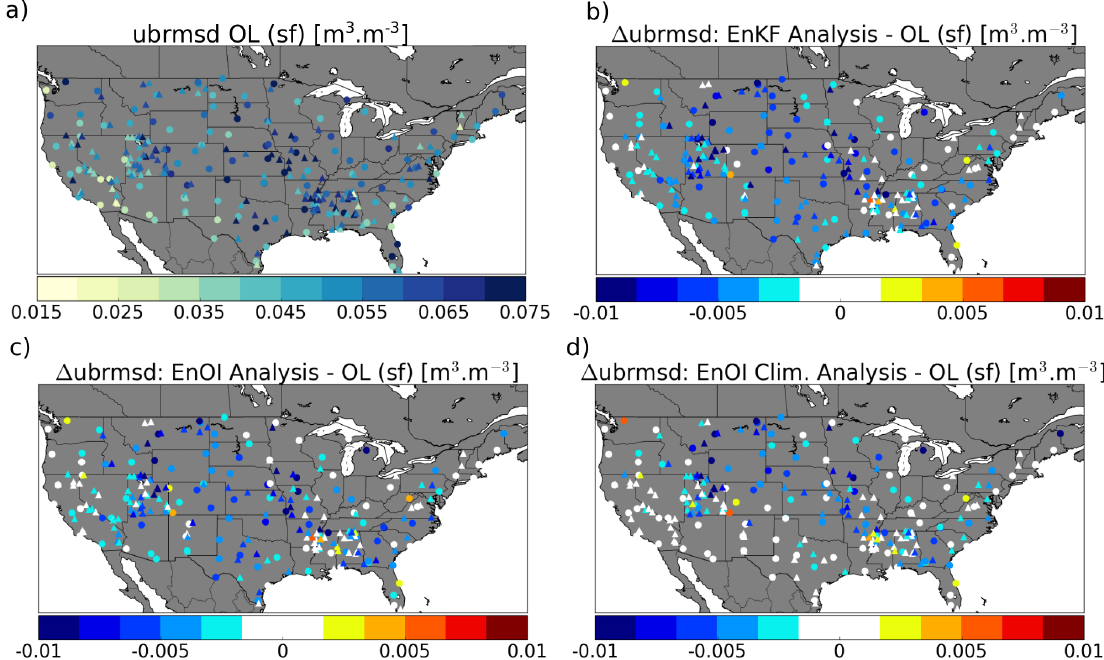
Figure 8. ( a ) unbiased root mean square difference (ubrmsd, m 3 m − 3 ) between the ensemble open-loop (eOL) surface zone soil moisture and the SCAN (triangles) and USCRN (circles) stations. Yellow/blue colours indicate low/high ubrmsd; ( b ) ∆ ubrmsd (EnKF minus eOL); blue/red colours indicate positive/negative impact of the analysis (229 of 259 stations improved); ( c ) ∆ ubrmsd (EnOI minus eOL) (201 of 259 stations improved); ( d ) ∆ ubrmsd (EnOI-Clim minus eOL) (197 of 259 stations